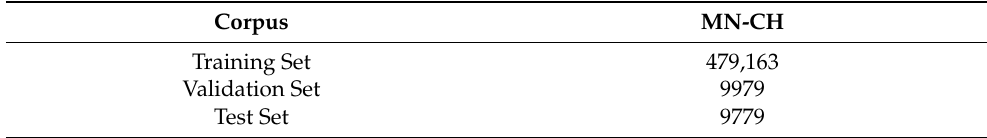
Table 1. Number of sentences in Traditional Mongolian-Chinese